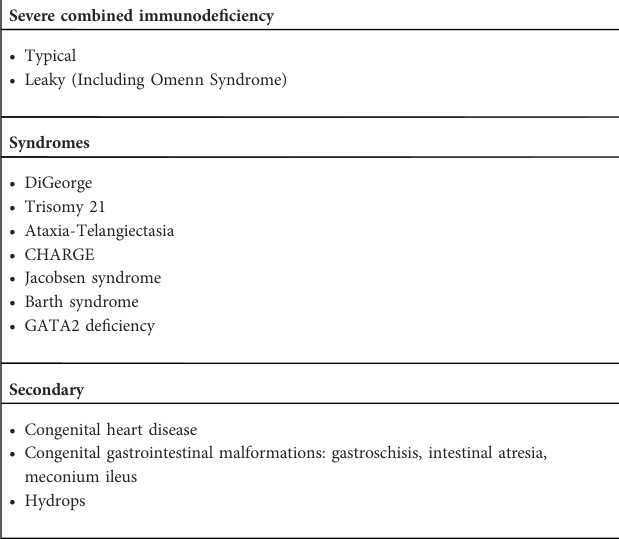
TABLE 3 Causes of low TREC detected on newborn screen. Severe combined immunode fi ciency